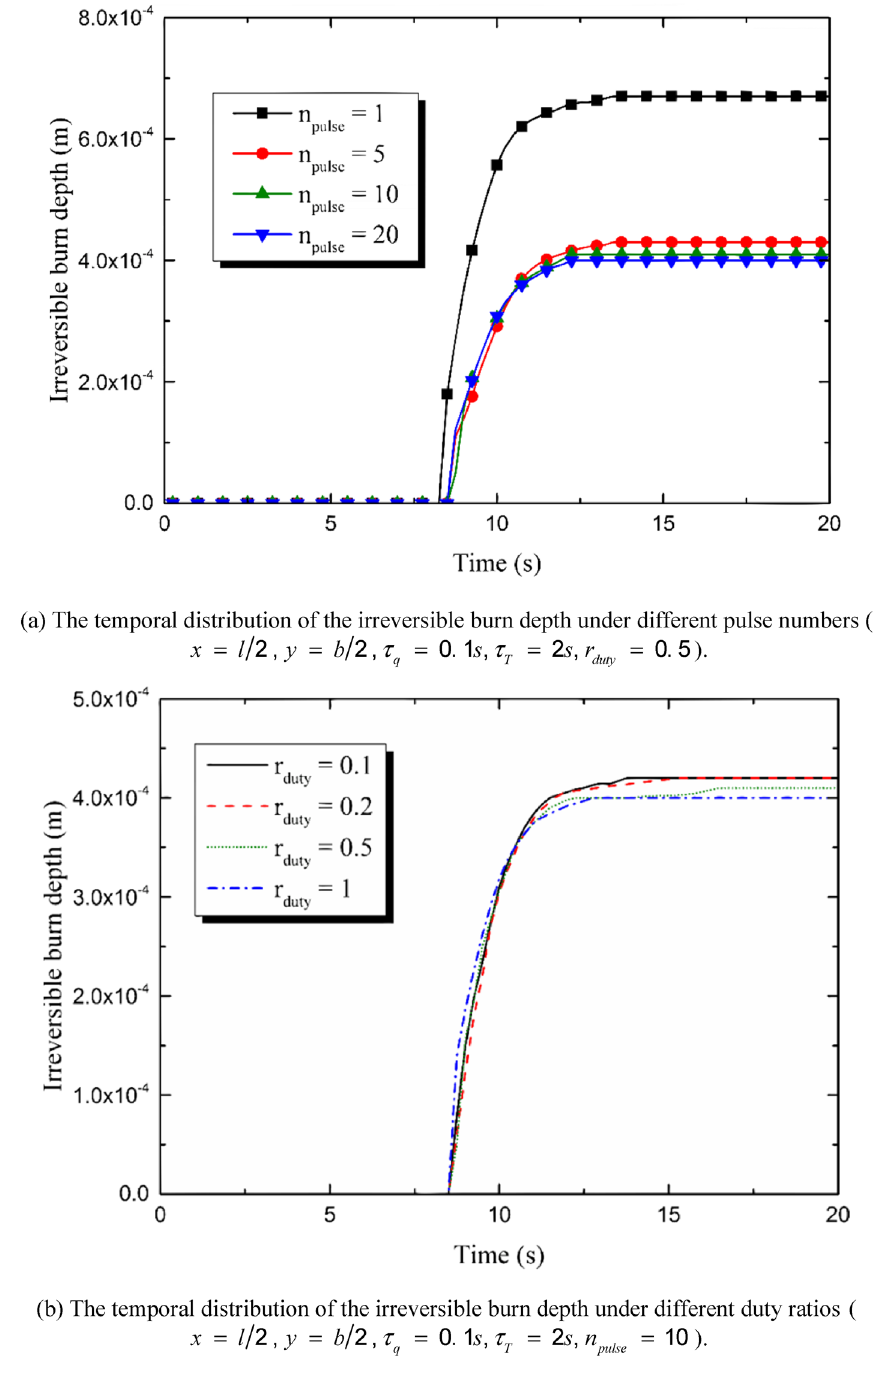
Figure 10. Influences of heat source parameters on the depth of the irreversible burn induced by the multi- pulse